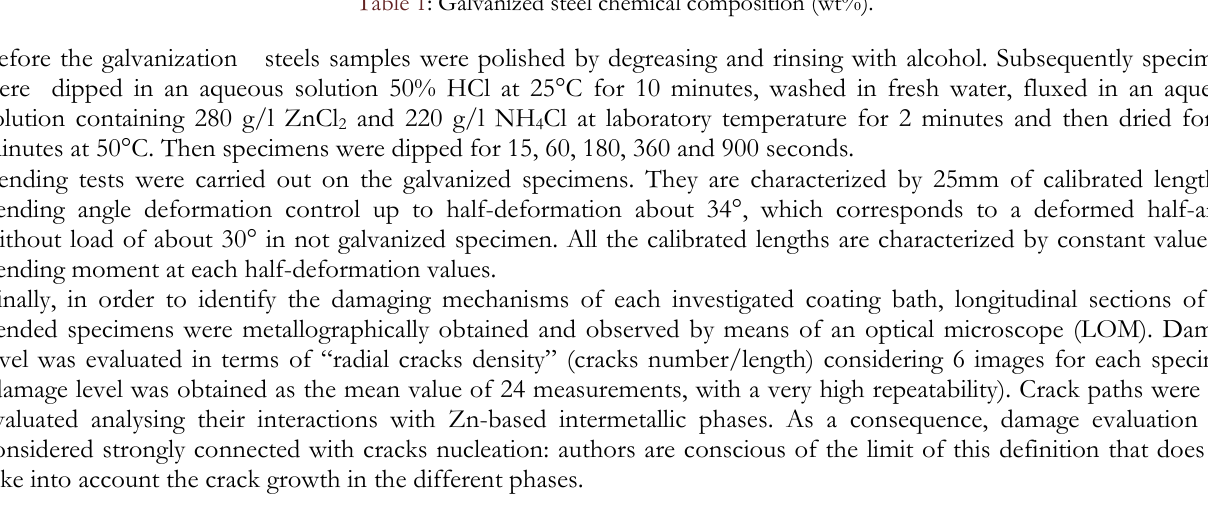
Table 1: Galvanized steel chemical composition (wt%).